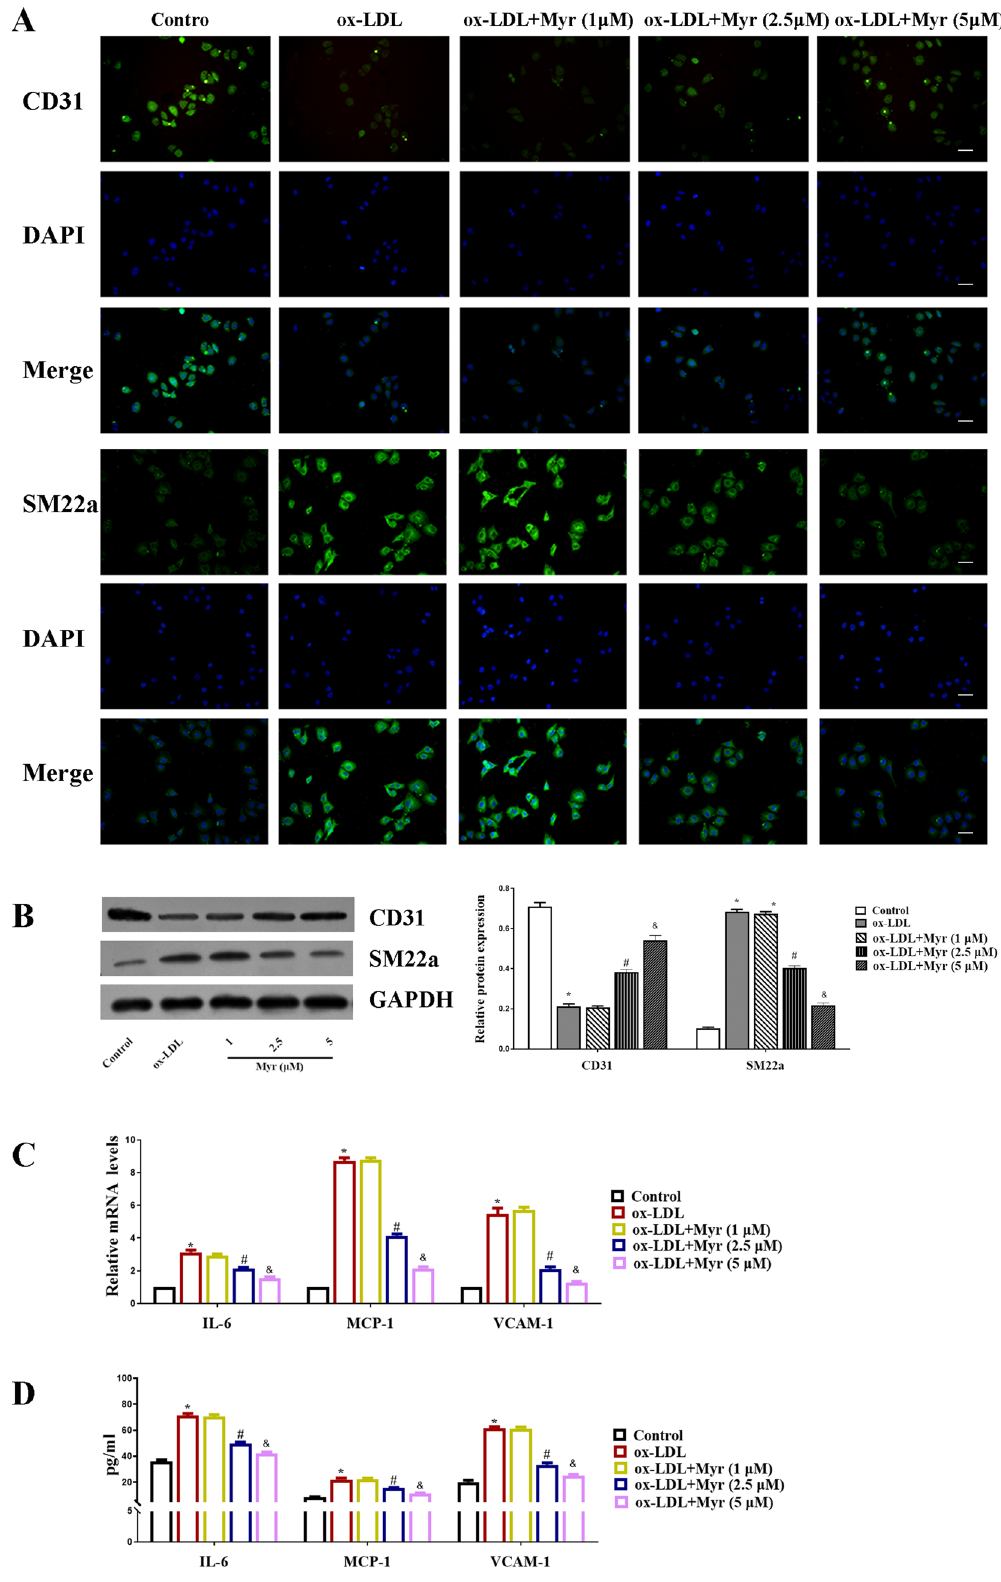
Figure 2. Myr inhibits the inflammatory response and EndMT in ox-LDL-induced HUVEC cells. ( A ) Representative immunofluorescence images of CD31 and SM22a expression in each group. Scale bar represents 50 μm. ( B ) Western blot analysis of CD31 and SM22a expression in HUVEC cells. ( C ) The mRNA levels of IL-6, MCP-1 and VCAM-1 in each group. ( D ) The protein levels of IL-6, MCP-1 and VCAM-1 were detected by ELISA assay. * P < 0.05 compared with control; # P < 0.05 compared with ox-LDL; & P < 0.05 compared with 2.5